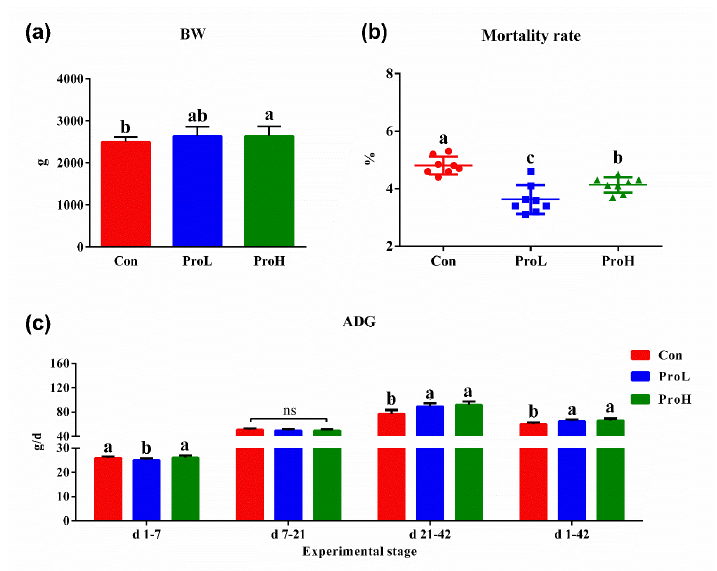
Figure 1. Effects of compound probiotic on the BW, mortality rate, and ADG in broilers. ( a ) BW; ( b ) mortality rate; ( c ) ADG. a, b, and c in the same figure represent a significant difference ( p < 0.05); ns represents no significant difference. Con birds were fed a basal diet; ProL birds were fed a basal diet added into 10 10 probiotics cfu/kg; ProH birds were fed a basal diet added into 10 11 probiotics cfu/kg ( n = 8).